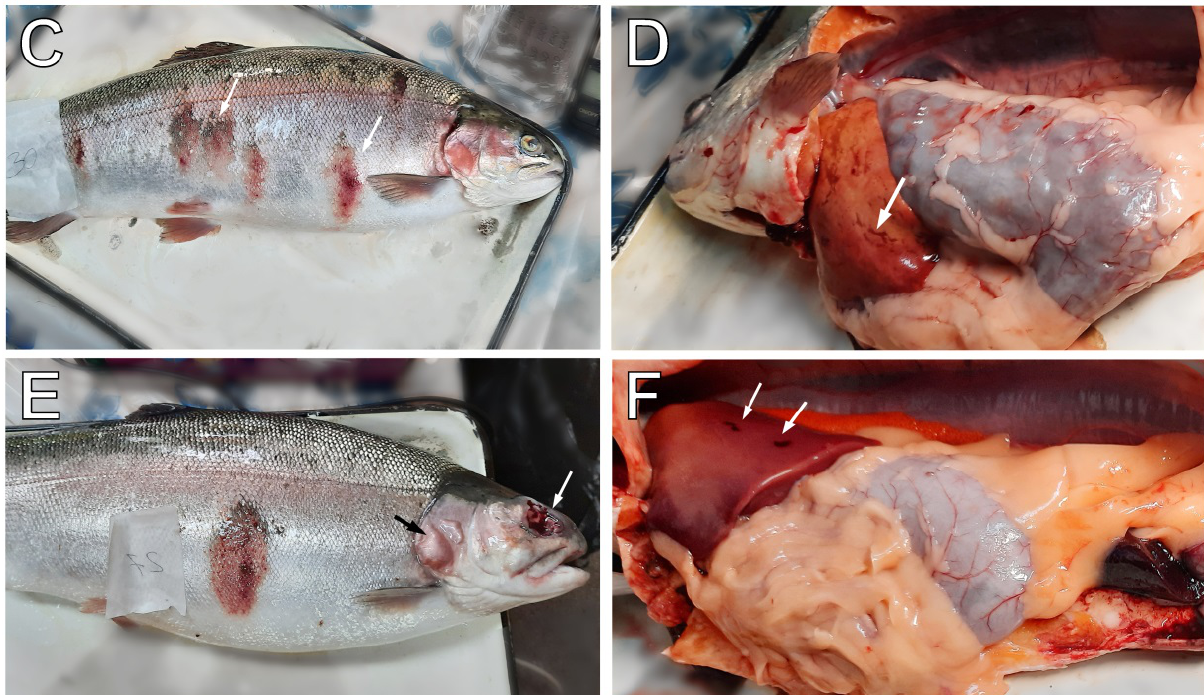
Figure 1. Representative anomalies of rainbow trout collected from a fish farm during a vibriosis outbreak with varying degrees of infection. ( A )—asymptomatic fish with insignificant signs of disease on the skin and fins (AS group). ( B )—dissection of asymptomatic fish with no hemorrhages in the body cavity (AS group). ( C )—fish with “red marks” on the skin (white arrows) indicating infection (IP group). ( D )—local hemorrhages (white arrow) in the liver of an infected trout (IP group). ( E )—blisters (black arrow) and complete eye loss (white arrow) in fish with severe skin lesions and ulcers (SL group). ( F )—hemorrhagic foci (white arrow) in the liver of severely affected fish (SL group).